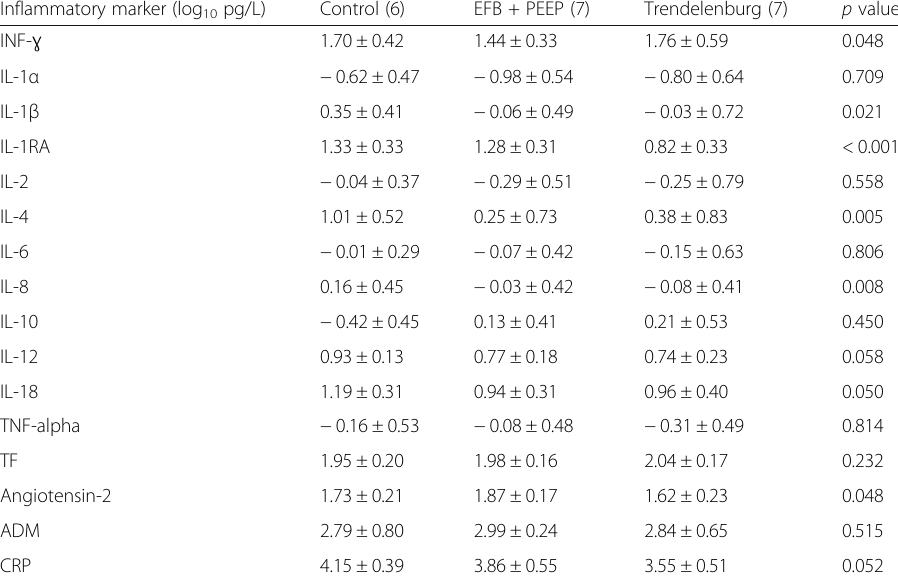
Table 4 Inflammatory markers among study